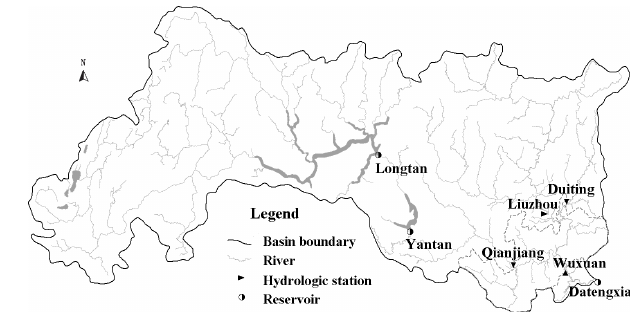
Figure 1. The hydrologic network of Datengxia